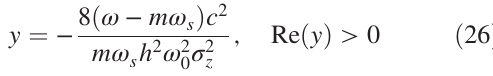
¼ 8 ω þ ω and the parameters of Fig. 2 for a bunch length of 0.07 rad (left) 0 r s